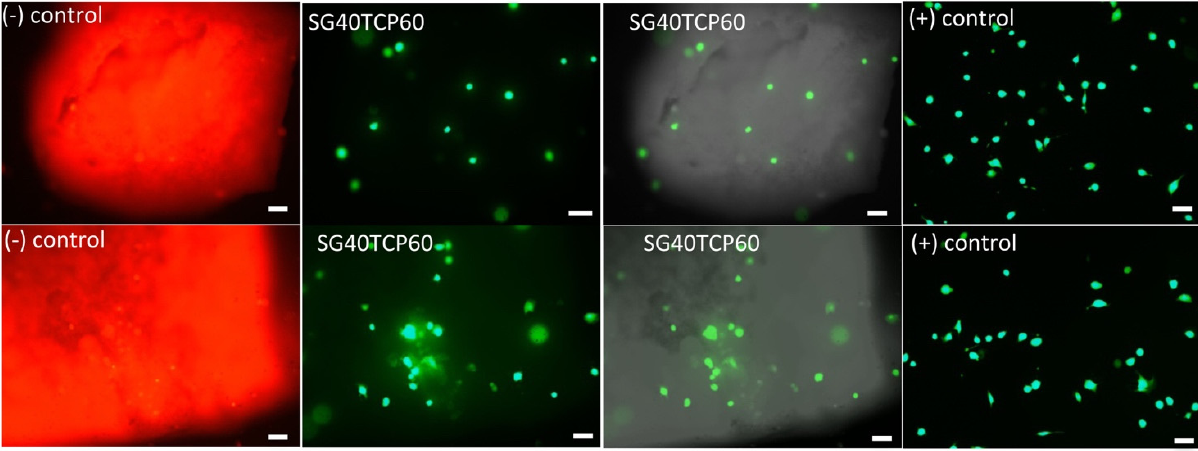
Figure 8. Live/Dead staining of HOB ® cells after 48 h in culture. Positive controls for control groups shown in last column. Images acquired in the fluorescence and Nomarski modes of a Leica DMLI LED inverted microscope. Live cells (green); dead cells (red); biomaterials (gray). Scale bar equals 20 µ m.